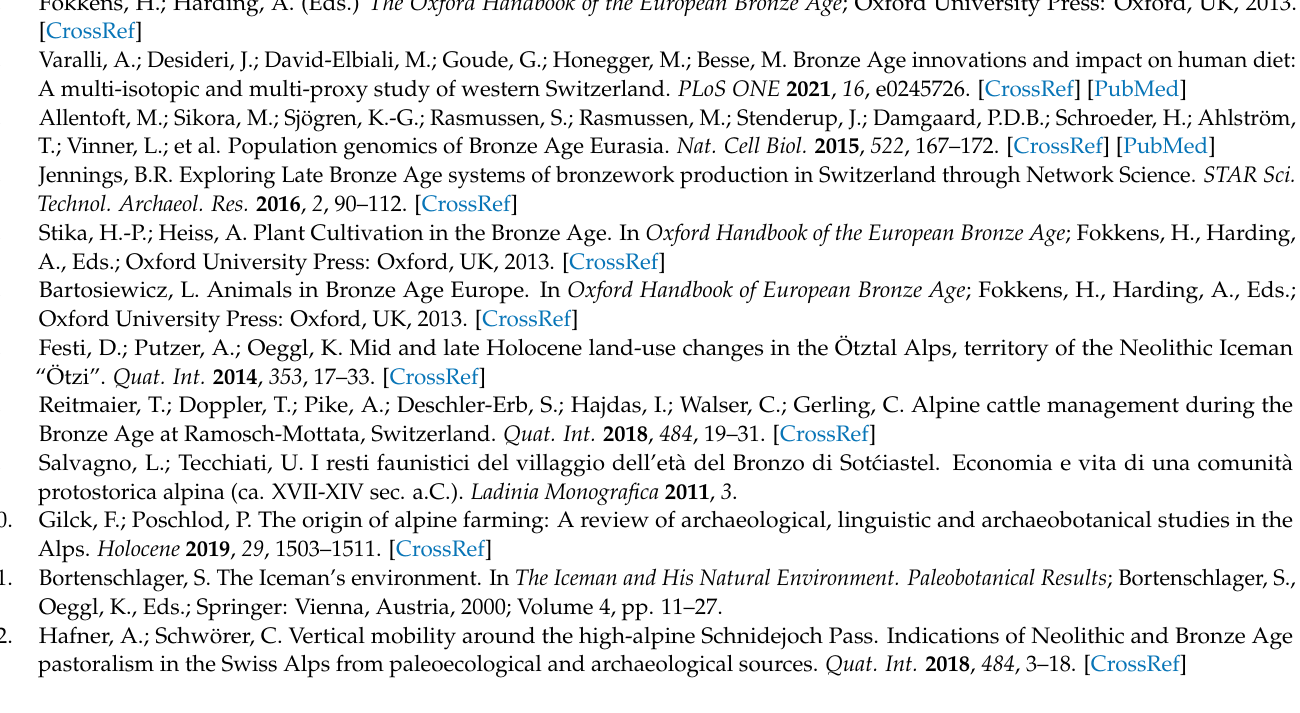
different cattle breeds. Table S1: Primer for PCR and sequencing used in this study. Table S2: Sequences used for genetic diversity measures and MDS